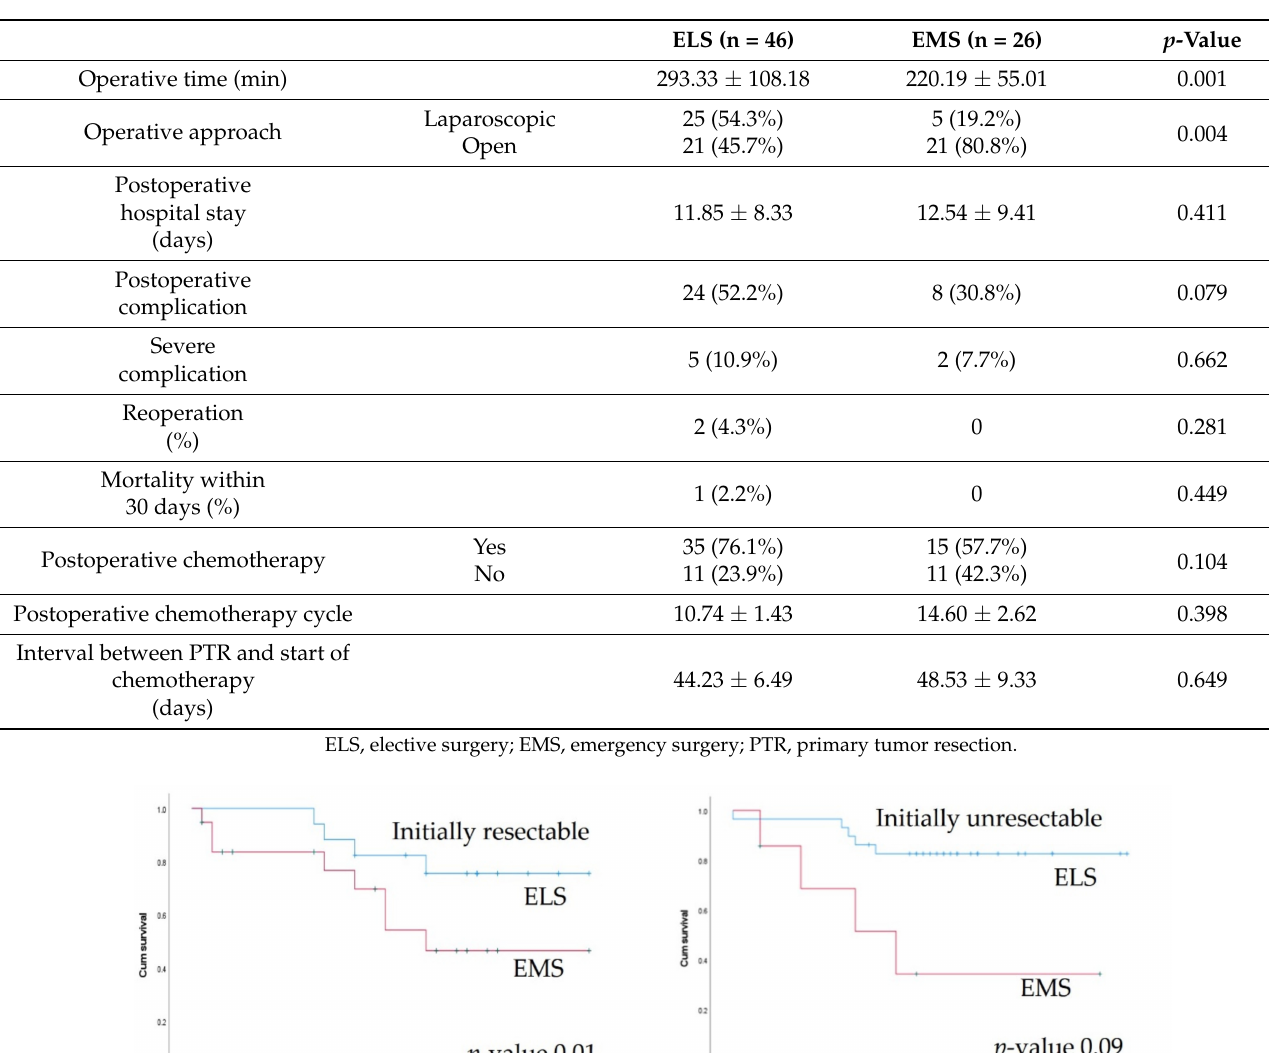
Table 3. Perioperative outcomes.